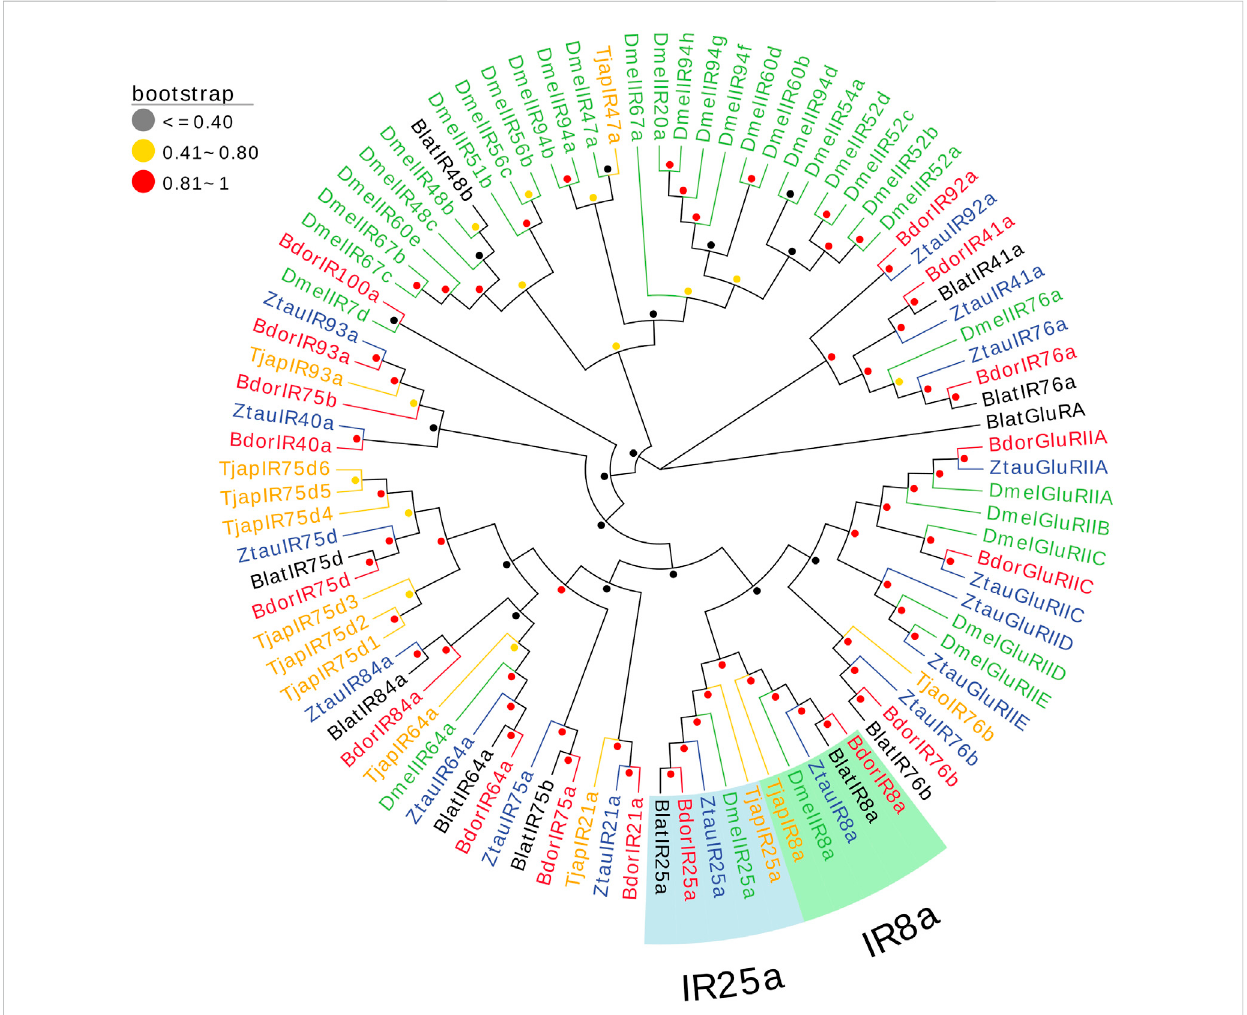
FIGURE 5 TheNJphylogeneticanalysisofIRsin T.japonensis , B.dorsalis , Zeugodacustau , B.latifrons ,and D.melanogaster .The TjapIR8a groupandTjapIR25a group are